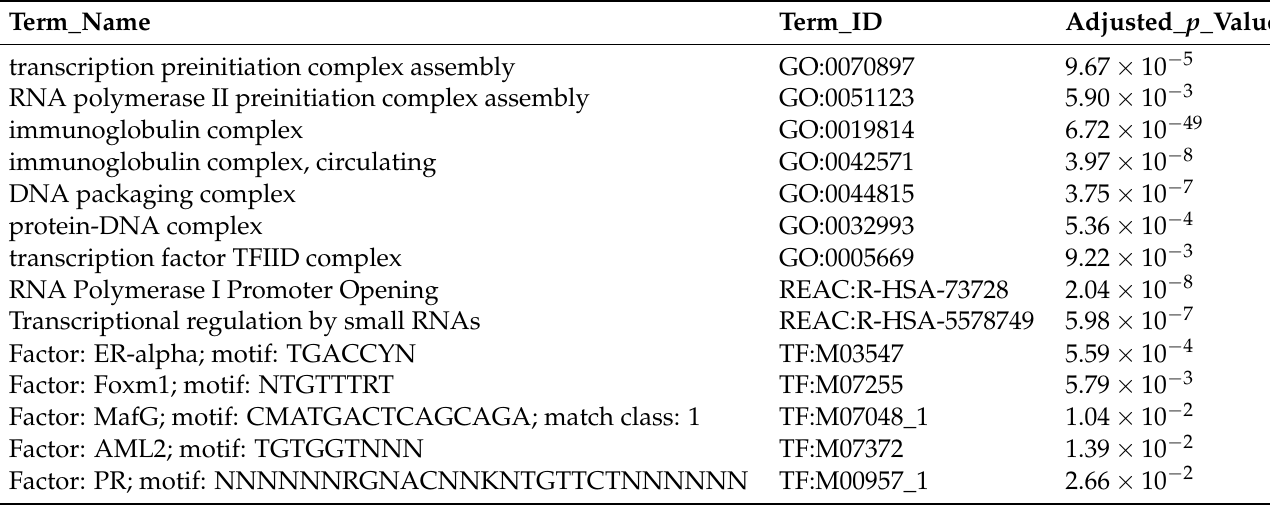
Table 1. Results of enrichment analysis of 90 min Hi-C data by g:Profiler.